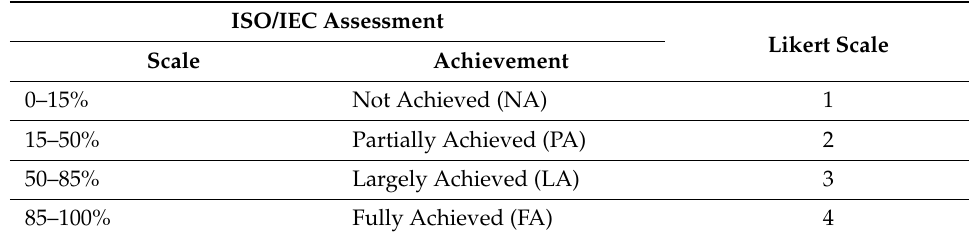
Table 4. Achievement Score.